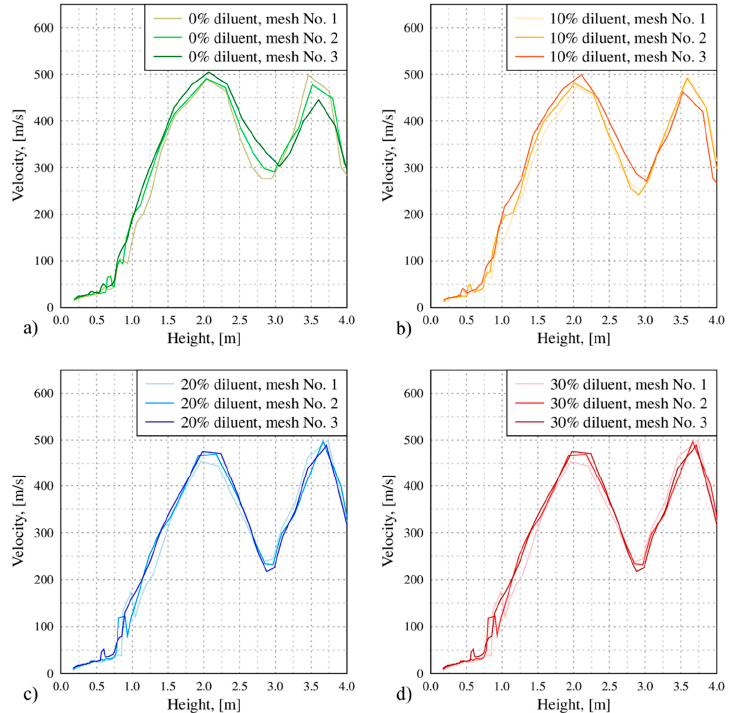
Figure 3. Comparison of meshes ( a ) 0% diluents, ( b ) 10% diluents, ( c ) 20% diluents, ( d ) 30% diluents (Zimont correlation).